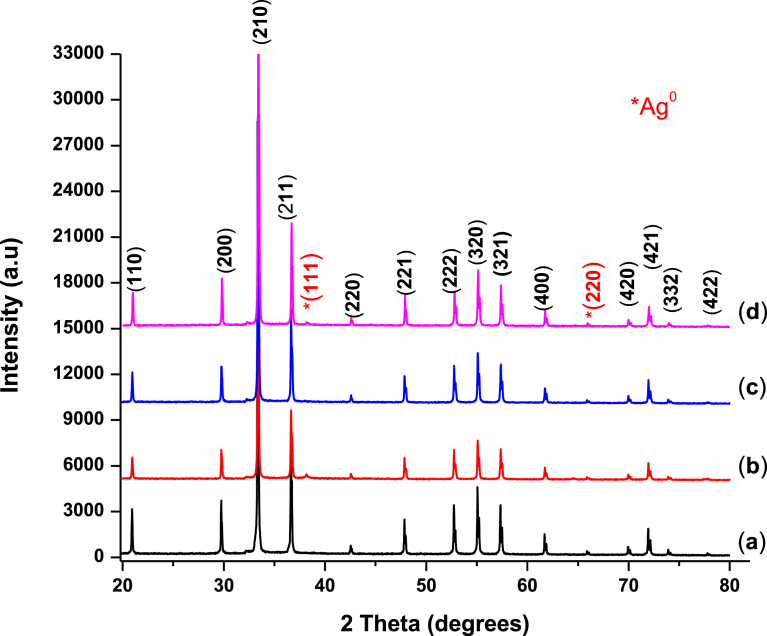
XRD patterns of Ag3PO4: (a) Pristine Ag3PO4; (b) Ag3PO4 after 4th run of photocatalysis and (c) Rejuvenated Ag3PO4 and (d) Ag3PO4 after 4.30 hours of photocatalysis.